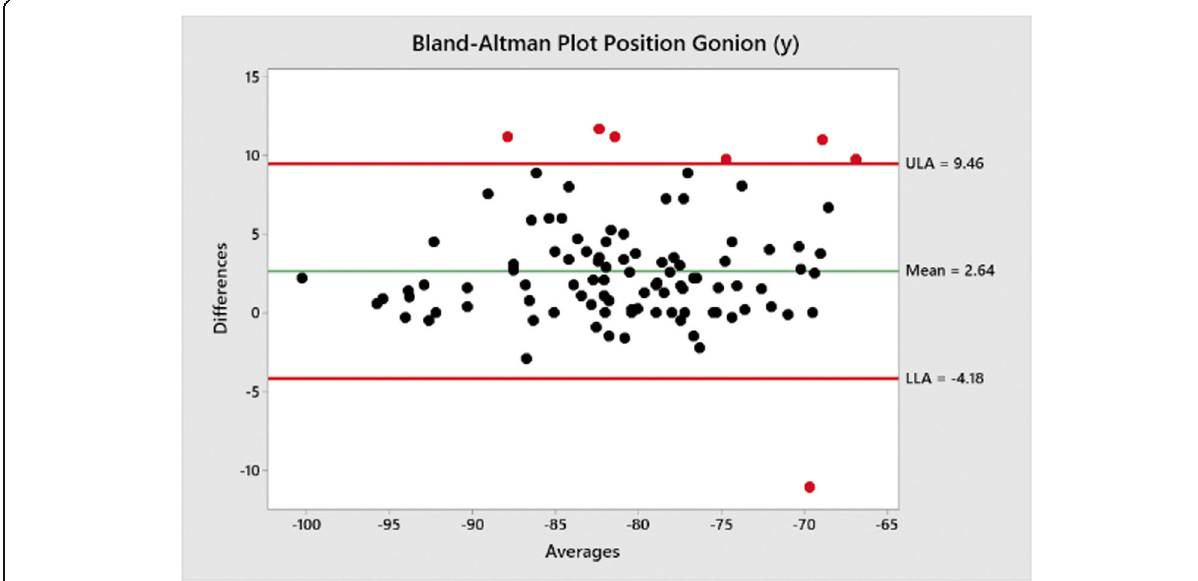
Fig. 3 Bland-Altman plot showing mean differences between traced position of Go ( y ) co-ordinate and estimated position by Sassouni+ analysis versus mean (average); the mean difference and limits of agreement are